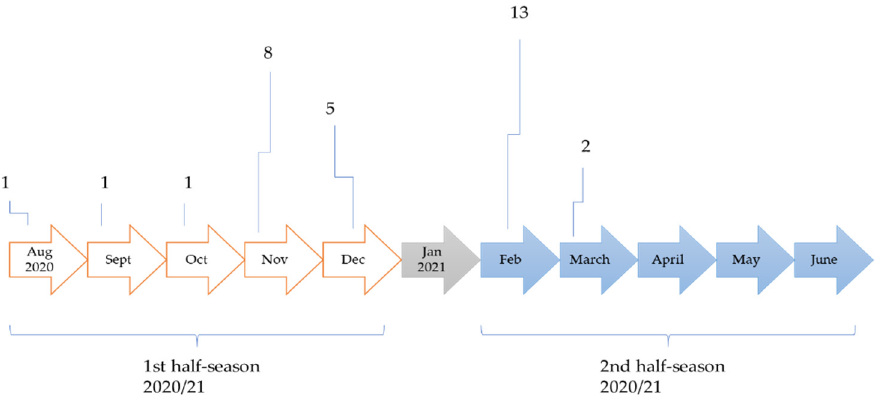
Figure 1. Positive COVID-19 findings during the competitive 2020/21 season in studied soccer team.